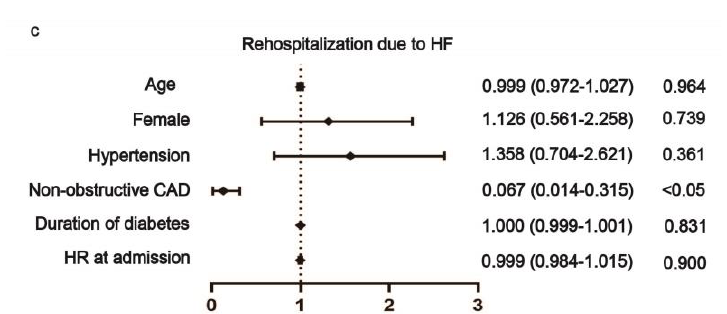
Figure 5. Association between risk factors and prognosis in DCM-HFrEF patients. Non-obstructive CAD was a negative predictor for both composite endpoint ( a ) and rehospitalization due to HF ( c ). Hypertension was a negative predictor for death of DCM-HFrEF patients ( b ). CAD: coronary artery disease; HR: heart rate.